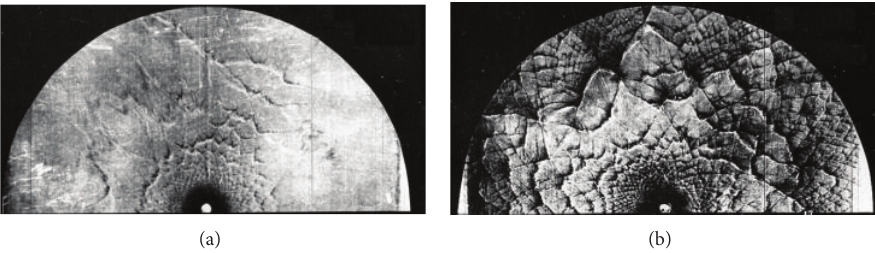
Figure 12: Smoked-foil imprints illustrated the threshold character of initiation of cylindrical DW: (a) DW destroyed at 𝐸 < 𝐸 ∗ (subcritical regime), (b) successful DW initiation at 𝐸 ≥ 𝐸 ∗ .